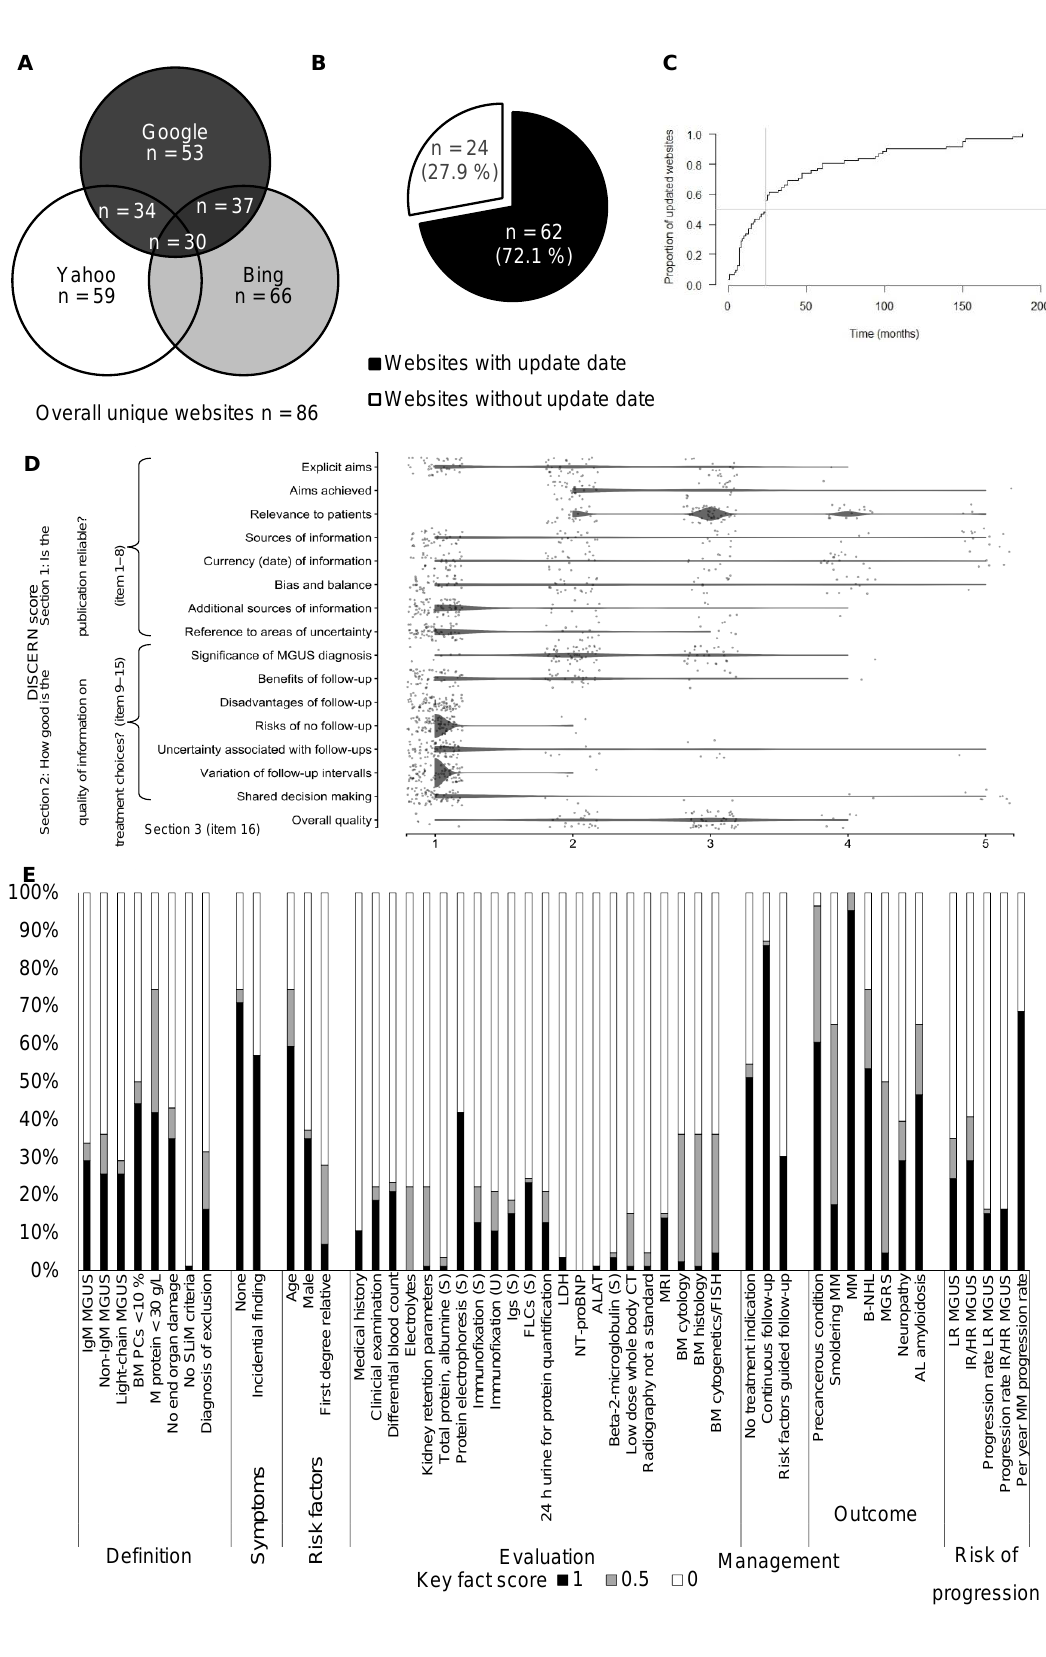
Figure 1. Characterization of unique websites. ( A ) Venn diagram indicating the number of duplicate overlaps between the search engines. Overall, 86 unique websites were identified. ( B ) Pie chart showing the proportion of websites